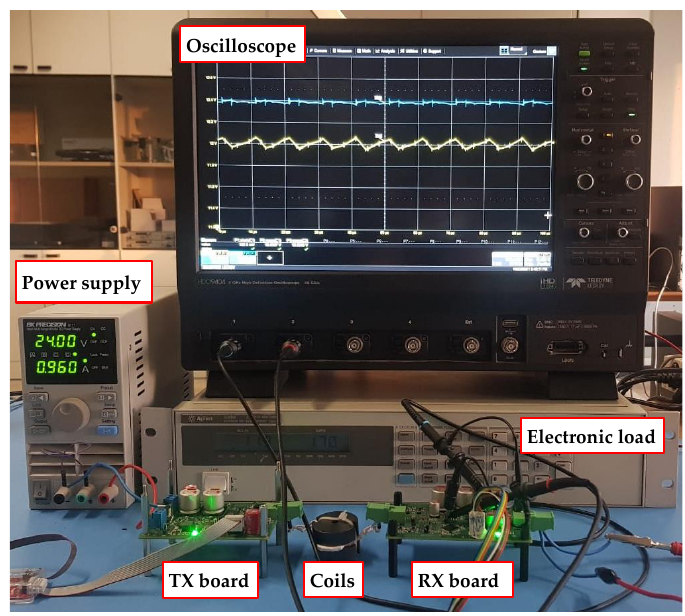
Figure 24. Experimental set-up used to test the developed PR-IPTS prototype.